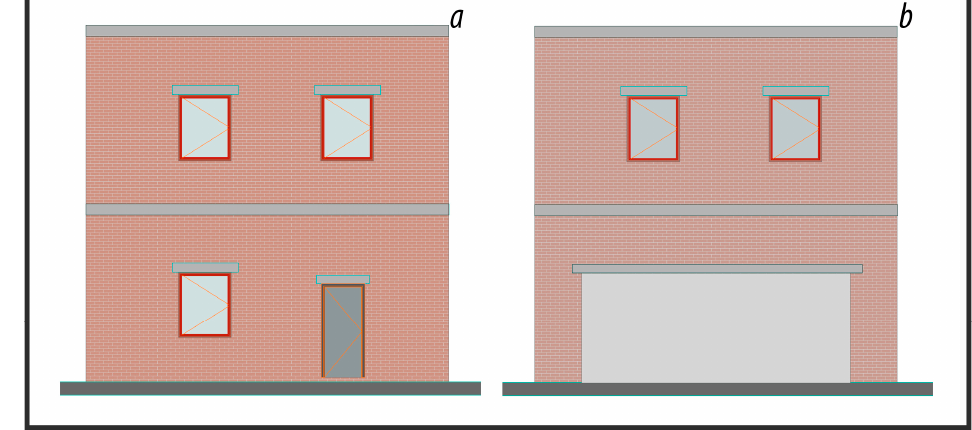
Figure 14. Soft/weak story: ( a ) None, ( b ) Available.